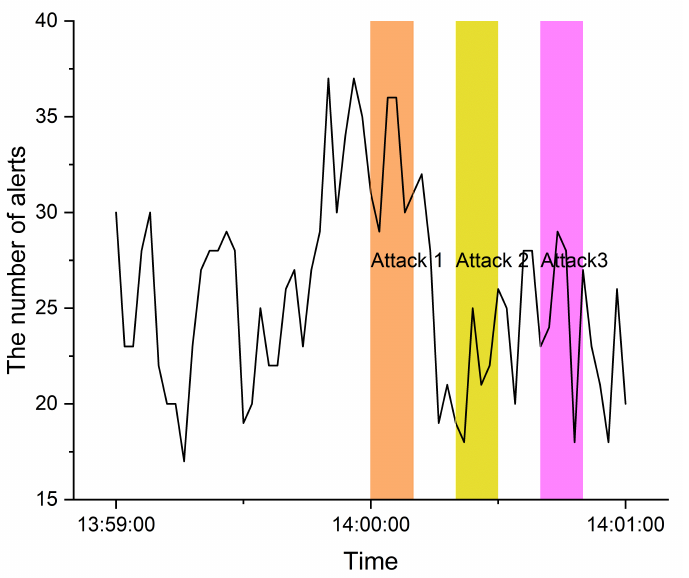
Figure 2. An example of the number of